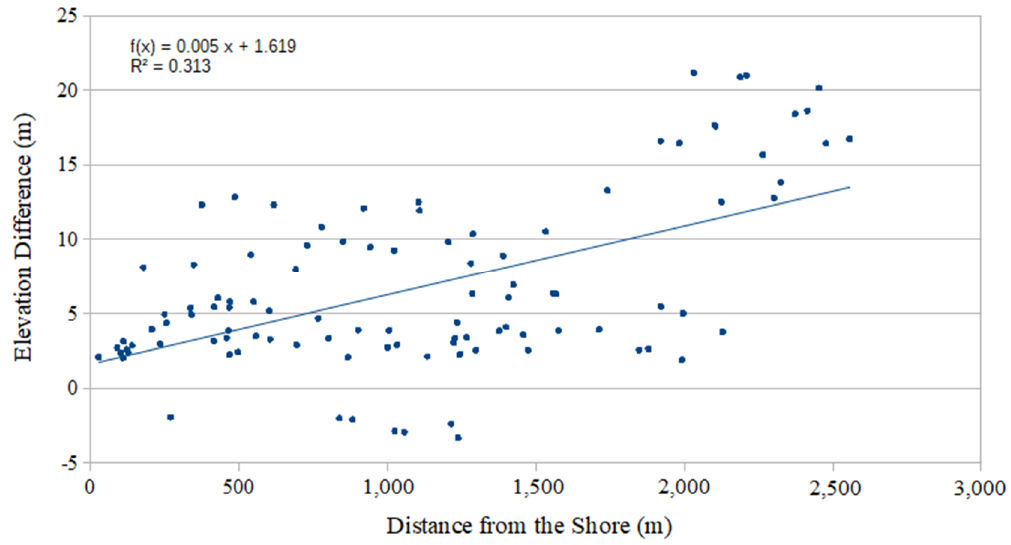
Figure 13. Elevation difference ( h DTM − h SONAR ) vs. distance from the shore—correlation analysis plot for the 1-sigma outlier subgroup (data points with absolute elevation differences > 5.2 m).